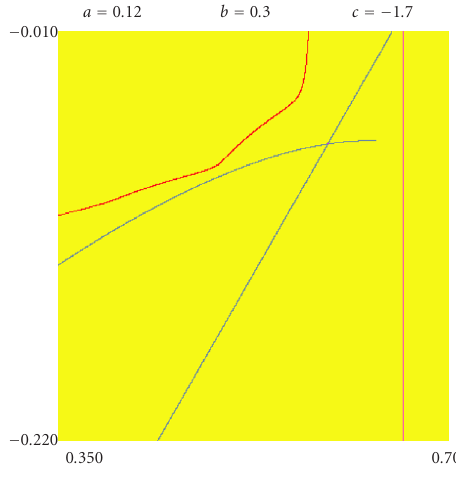
Figure 4.2. Enlargement of a portion of Figure 4.1.